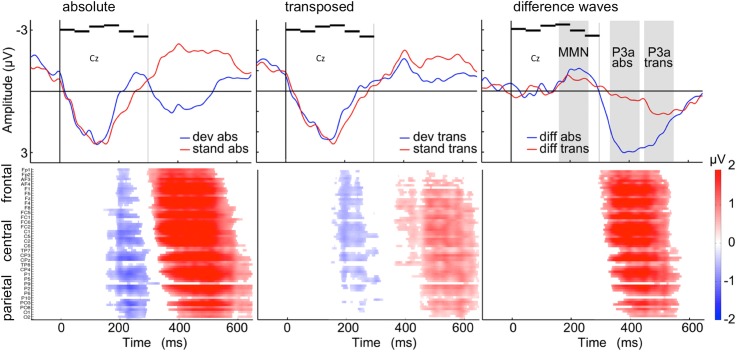
Grand-averaged ERPs, difference waveforms and results of the cluster-based permutation test.Top: Grand-averaged (N = 18) ERP waveforms at electrode Cz for train-lengths 2, 3, 6, and 12 for deviants (blue) and standards (red) in the absolute repetition condition (left) and transposed repetition condition (middle). Difference waveforms (right) of deviant minus standard are shown for the absolute repetition condition (blue) and for the transposed repetition condition (red). Sound pattern (6 horizontal black bars) onset was at the crossing of the two axes (0 ms) and sound pattern offset was at 300 ms as indicated by the vertical grey line. Please note, that a pattern change could only be detected at the onset of the second segment, that is after 50 ms. Grey shades in the difference wave plots indicate 100 ms time window of MMN and P3a components. Bottom: Diagrams illustrating significant differences (p < 0.05) between ERPs to deviants and standards from the absolute repetition condition (left) and the transposed repetition condition (middle) according to cluster-based permutation tests. Red and blue portions indicate time points/electrodes in which the ERPs to deviants are more positive and negative, respectively. Color brightness indicates the amplitude of the difference. White portions indicate time points/electrodes at which no significant differences were found. In both conditions, a negative deflection is found around 200 to 300 ms and a positive deflection is found between 350 and 600 ms after stimulus onset. The diagram in the right column shows significant differences between the difference waveforms of the absolute and the transposed repetition condition. Note, that only in the time range of the positive component significantly different component clusters were observed.